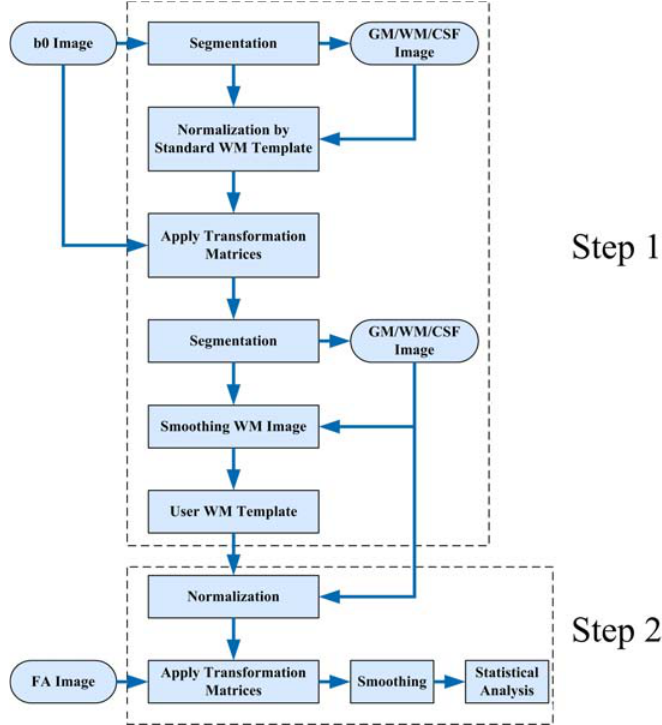
Fig. 2. Data processing flowchart for